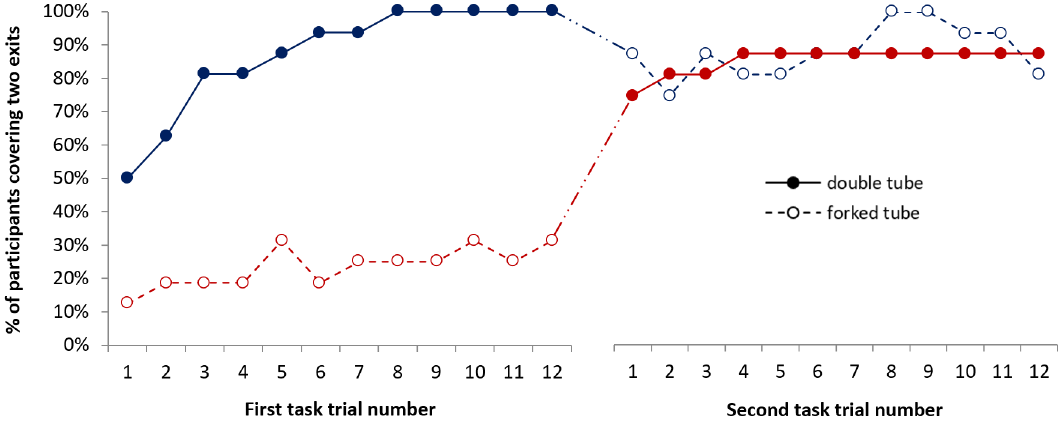
Fig 2. Percentages of 2.5-year-olds covering two exits across all 12 trials of the forked and double tube tasks. The red line represents the group who completed the forked tube task first, whereas the blue line represents the group of children who completed the double tube task